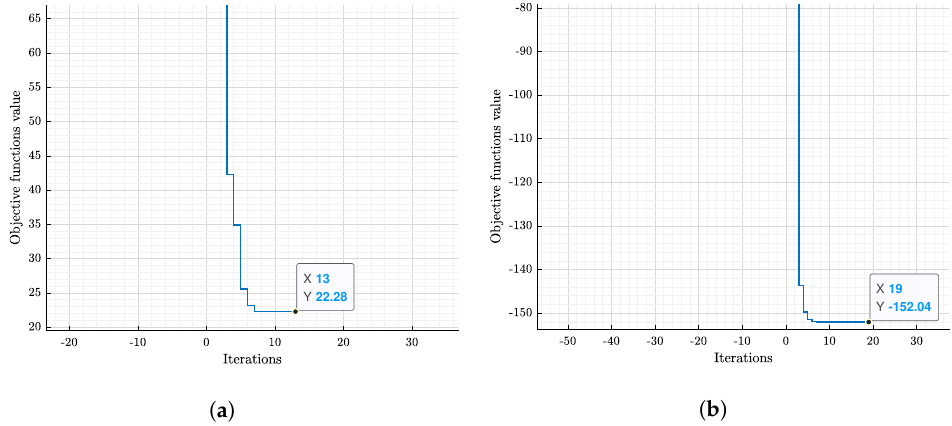
Figure 10. ( a ) The fitness curve for the BFGS algorithm when d = 6 for a BBOB problem instance randomly selected from the f1 class. ( b ) The fitness curve for the BFGS algorithm when d = 11 for a BBOB problem instance randomly selected from the f1